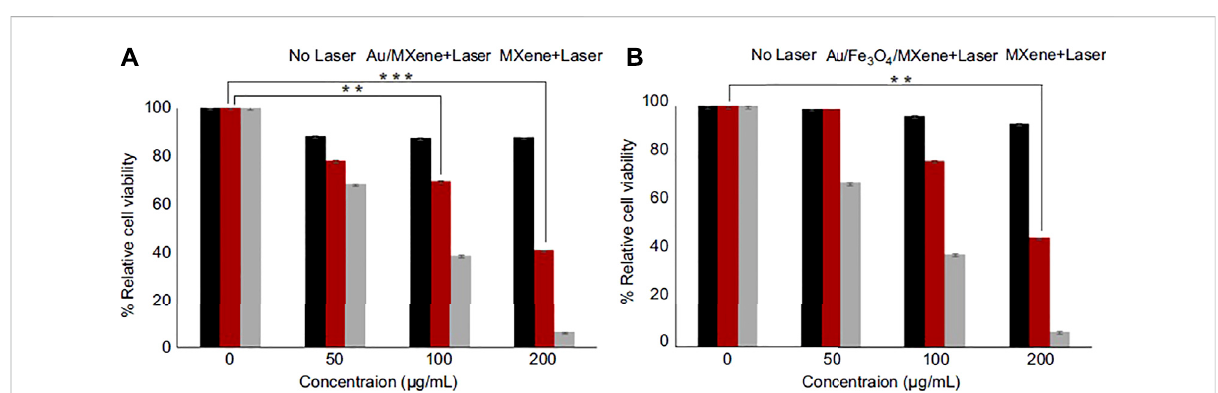
FIGURE 6 The relative viability of MCF7 cells since incubation (various concentrations) (A) Au/MXene and (B) Au/Fe 3 O 4 /MXene and Ti 3 C 2 (MXene) following by NIR 808 nm laser radiance with a might density of 1.0 W/cm 2 for 5 min Standardized to control (without laser treated cells) (Hussein et al.,